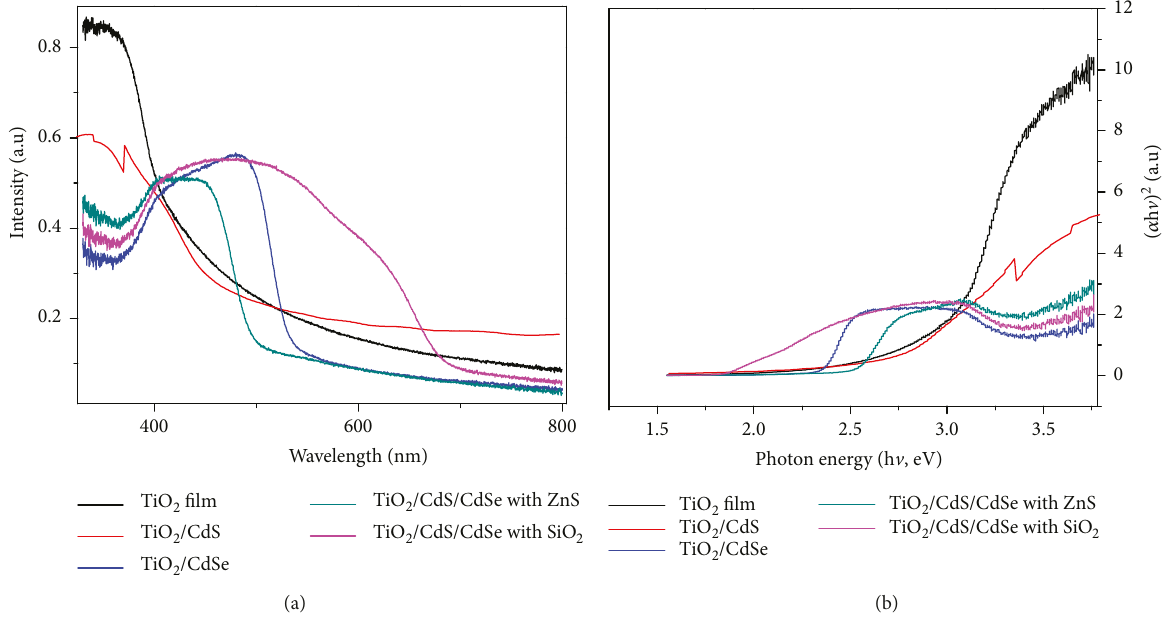
Figure 2: (a) UV-Vis of di ff erent photoanodes and (b) plot ( α h ν ) 2 versus the photon energy (h ν ) of di ff erent